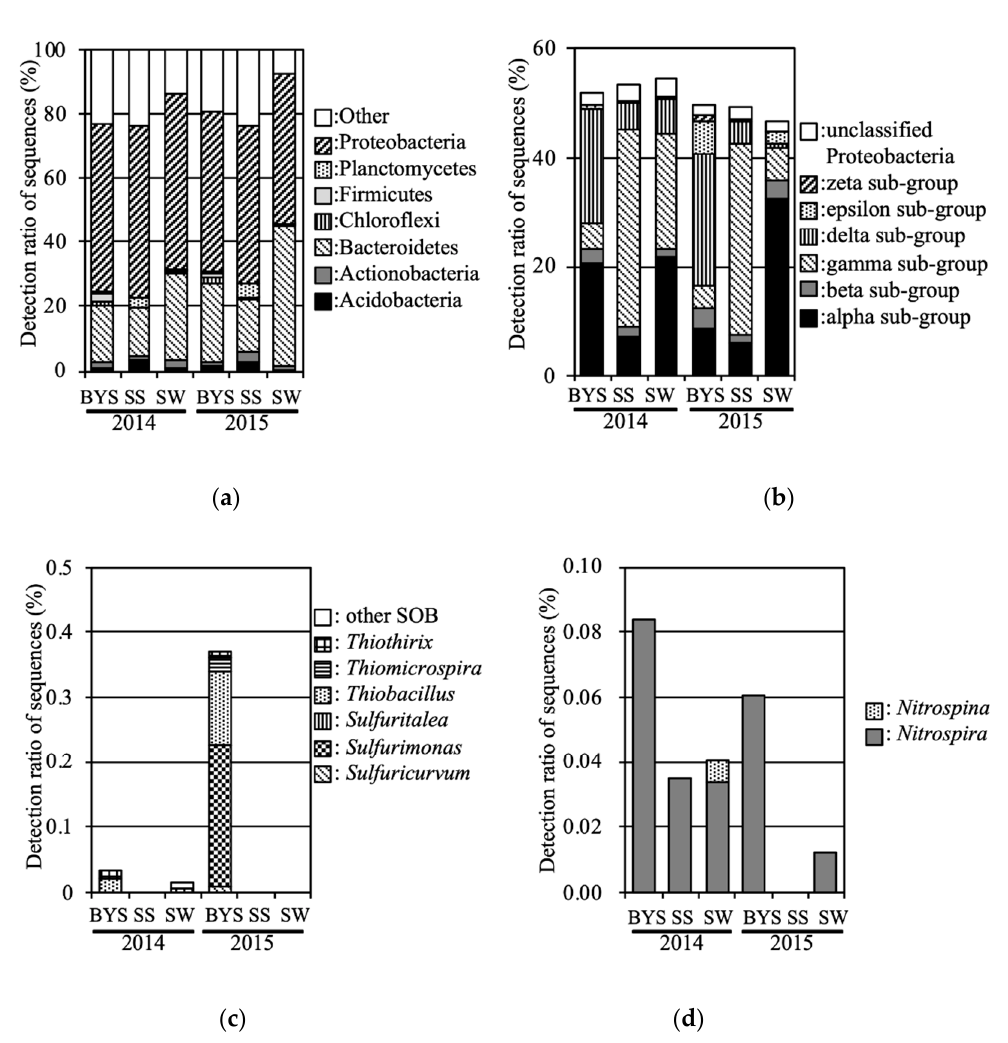
Figure 7. Relative abundance levels in the marine samples: ( a ): phyla, ( b ): Proteobacteria subgroups, ( c ): SOB, ( d ): NOB.